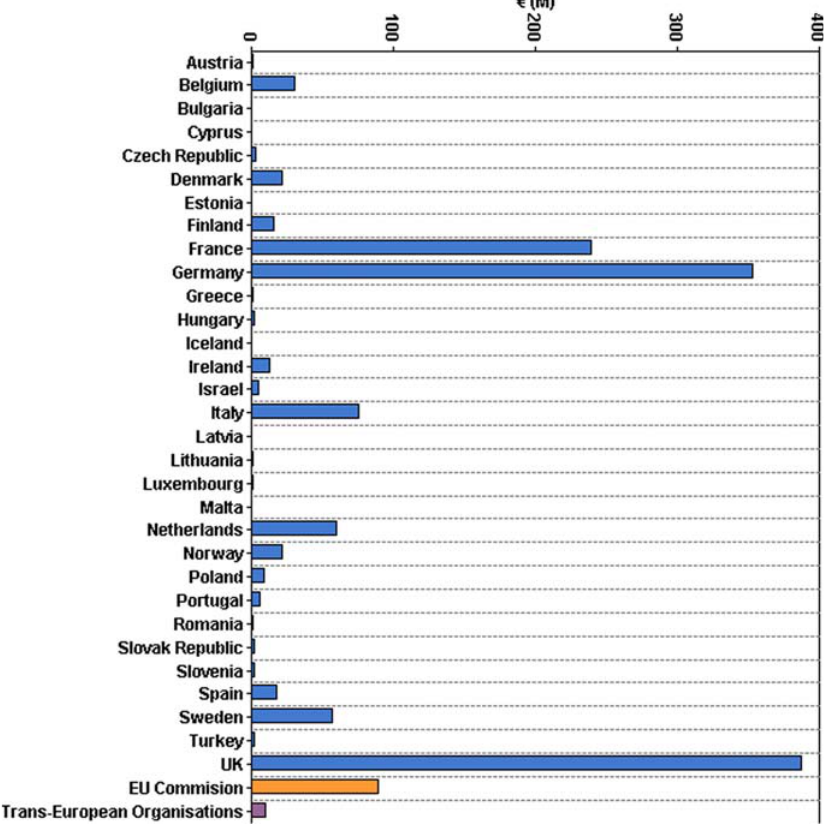
Figure 1. Direct Cancer Research Spending by Country, including European Commission and Trans-European